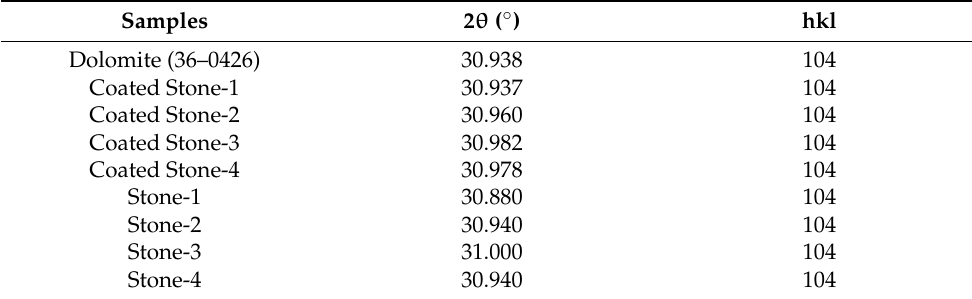
Figure 2. Composition of treated samples. ( a ) XRD, ( b ) Raman, ( c ) FTIR. Table 2. 2 θ degree of test samples.